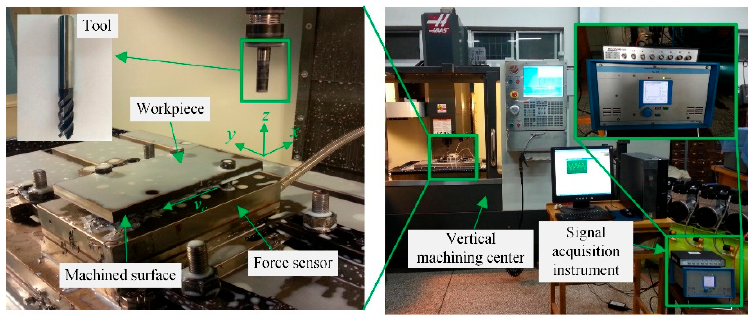
Figure 1. Milling experiment and force measuring equipment.